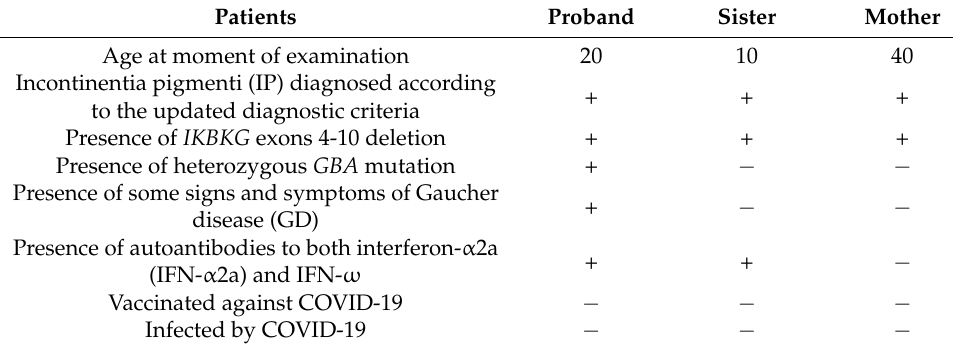
Table 1. Basic data concerning the examined